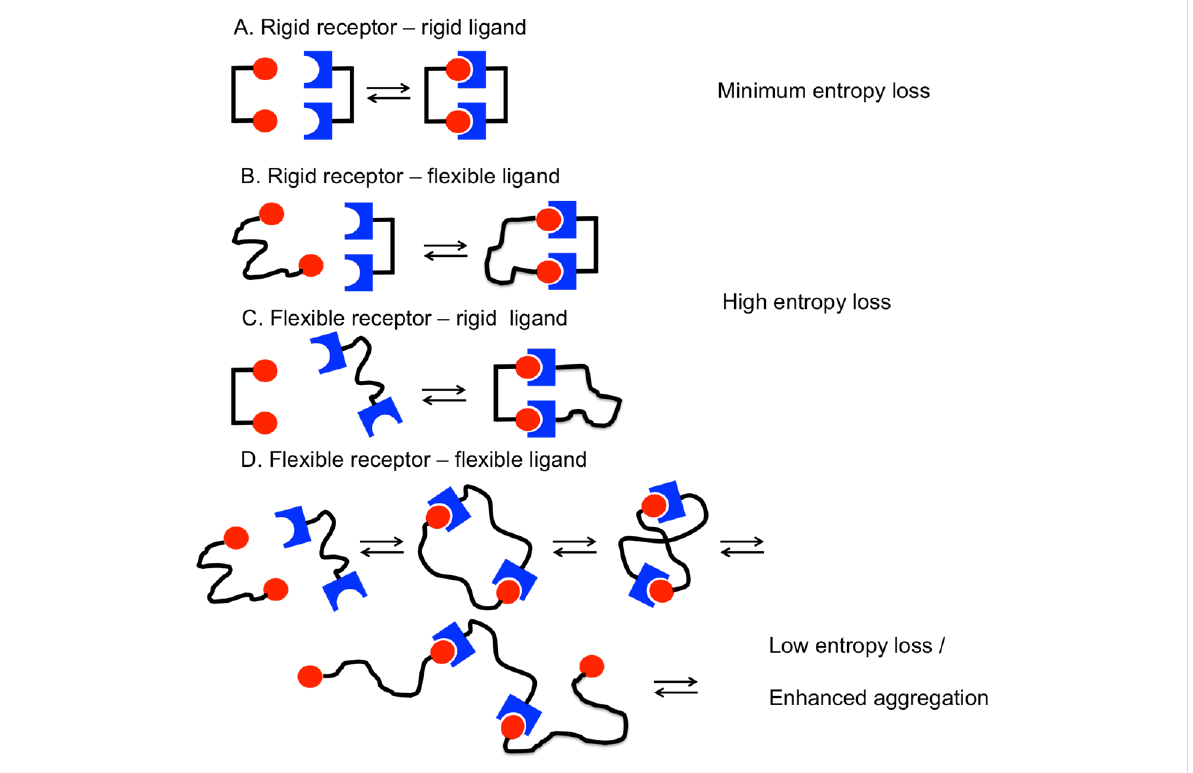
Figure 1: Comparing the entropy loss during ligand–receptor interactions in dependence of the rigidity of the